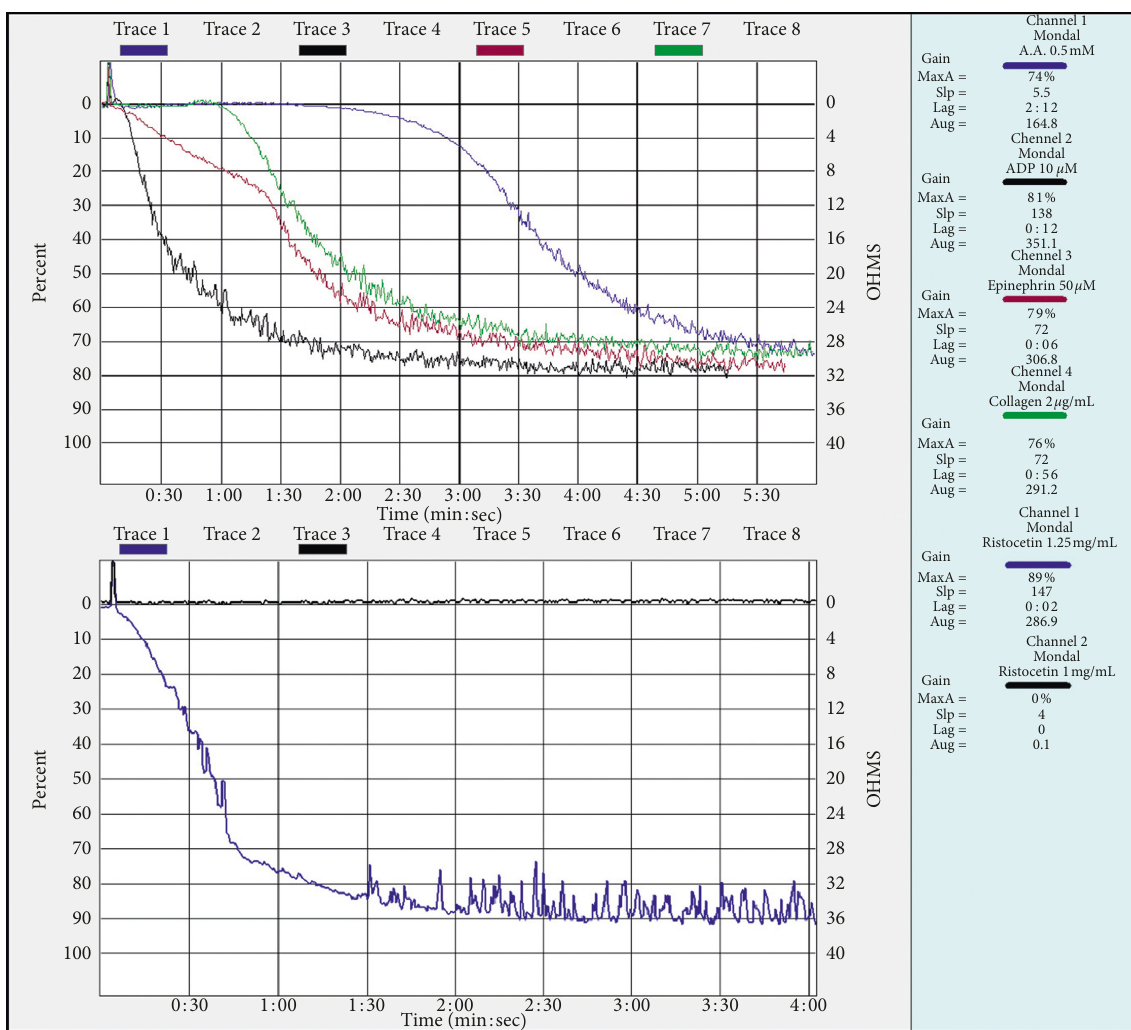
Figure 2: Platelet aggregation study by LTA at 3 months follow-up showing a normal response to all of the prothrombin time (PT) 13 sec; activated partial thrombo- plastin time (aPTT) 29 sec, and fibrinogen level 260 mg/dl.